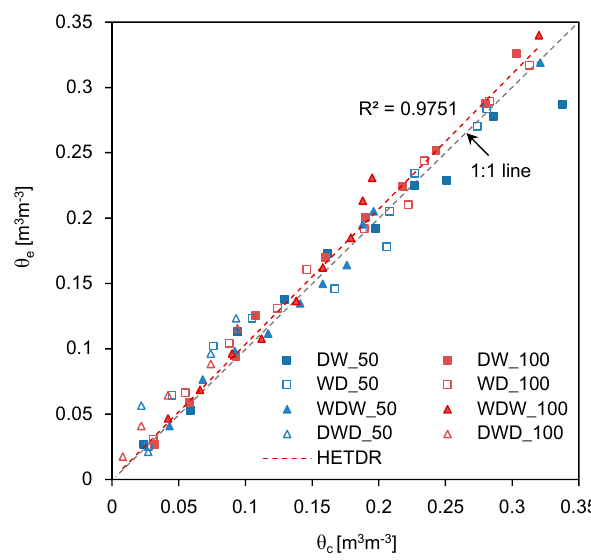
Figure 17. Relationship between the SWCs estimated through the HETDR and conventional TDR probes. θ e and θ c denote the SWCs estimated from HETDR and conventional TDR probes, respectively.